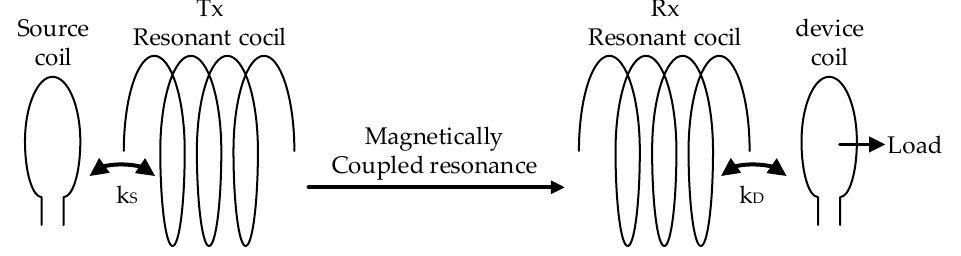
Figure 2. Wireless power transmission system of an electric vehicle.